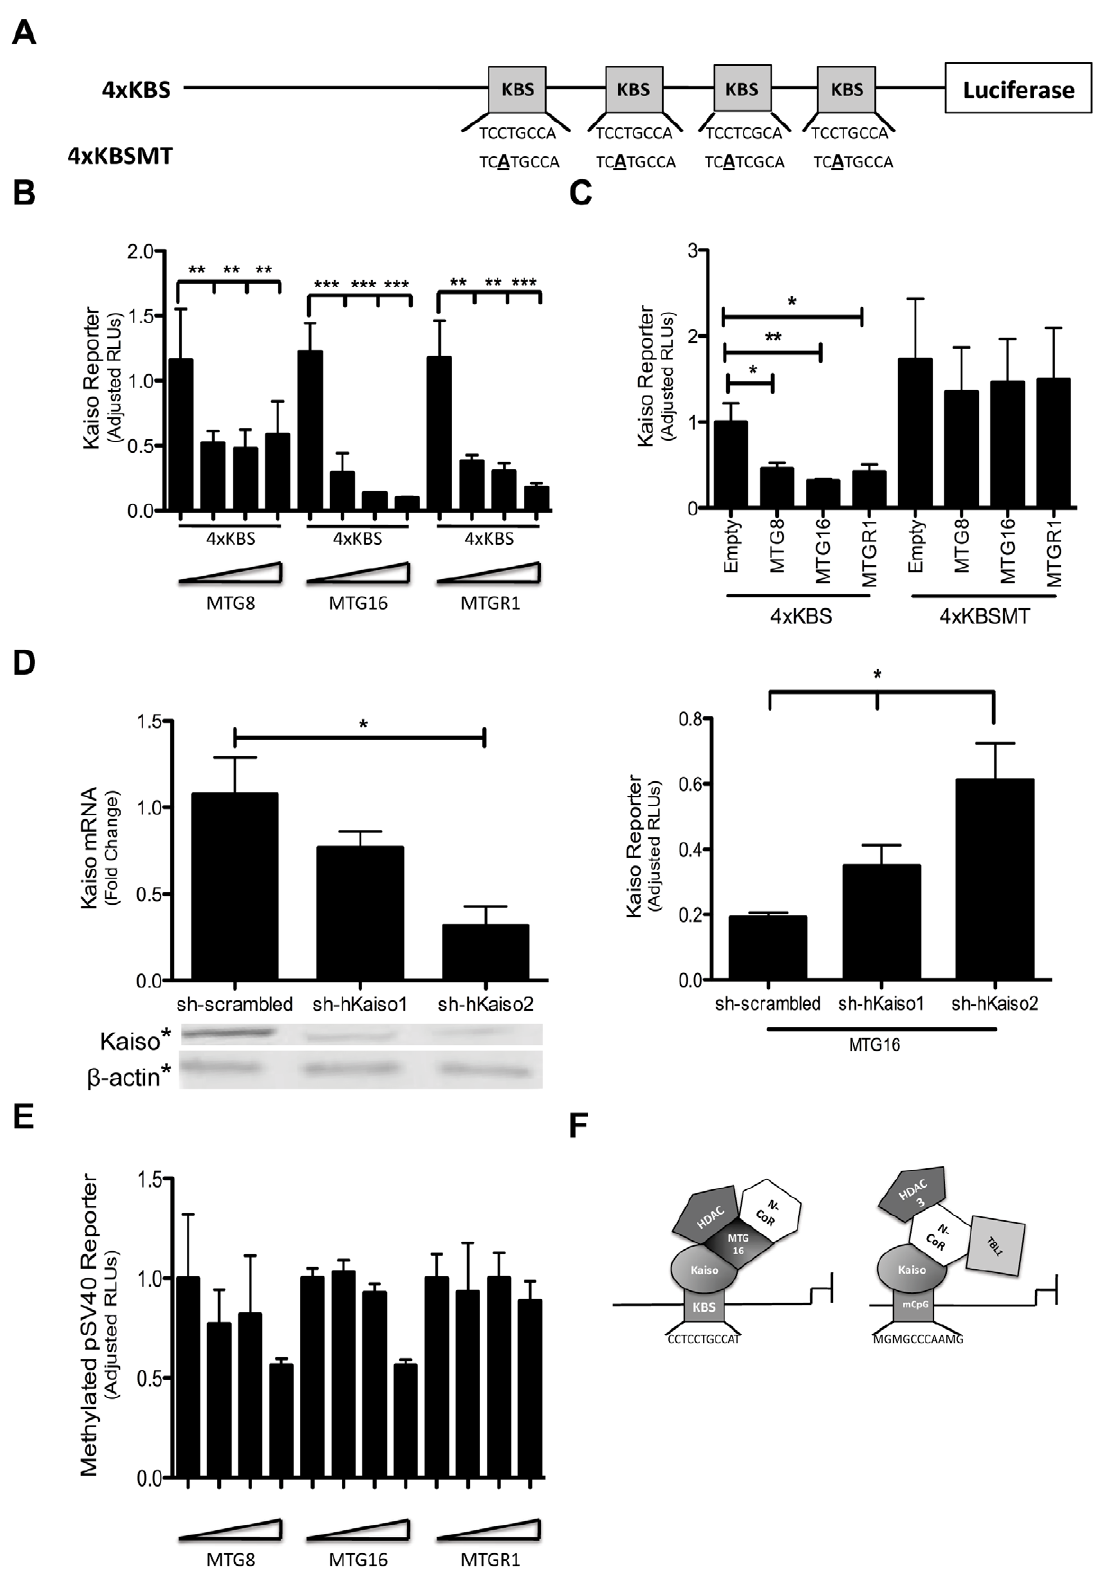
Figure 3. MTG family members repress the Kaiso binding site reporter (4 6 KBS). A. Composition of the KBS reporter constructs. The 4 6 KBS reporter contains four consensus Kaiso binding site sequences followed by a luciferase gene. The mutant reporter (4 6 KBSMT) contains a C R A transversion in the Kaiso binding sites which abolishes Kaiso binding. B. 4 6 KBS artificial promoter assays in HCT116 cells upon titration of MTG family members (0 ng, 200 ng, 400 ng, 800 ng). The graph shows the fold-change in luciferase activity relative to the control reporter, pGL4-TK hRLUC, after